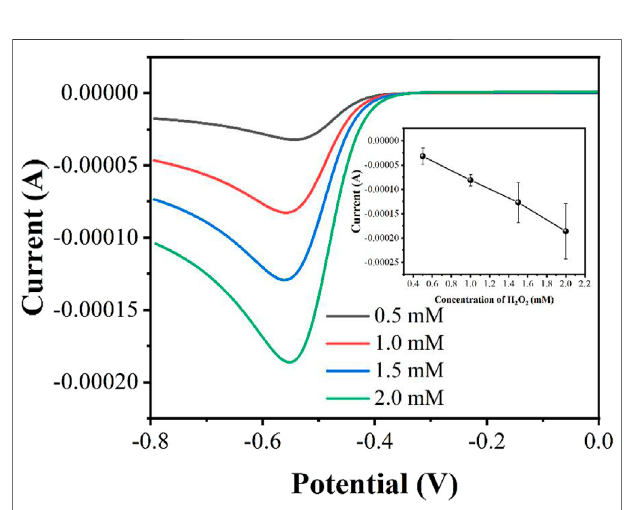
FIGURE 3 | Effect of the H 2 O 2 concentration on the determination performance ( n (cid:1) 3).